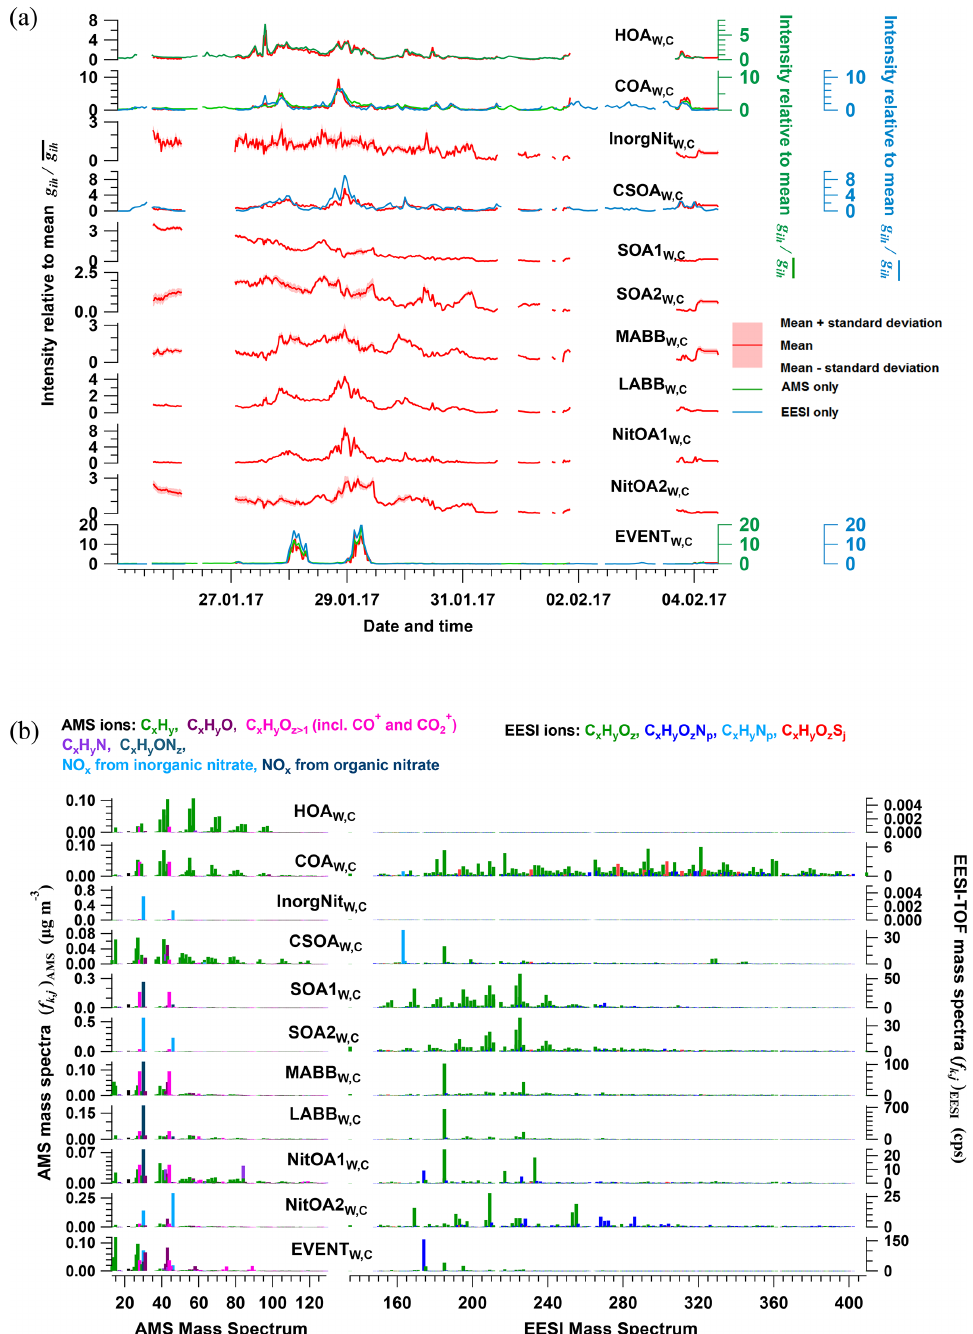
Figure 4. Average factor time series (a) and factor profiles (b) , which are calculated as the mean of all accepted bootstrap runs (308 runs in total). In panel (a) , the average factor time series are shown in red, and corresponding AMS and/or EESI-TOF factors from standalone PMF are shown in green and blue, respectively. Shaded areas represent the standard deviation across all accepted runs and are summarised in Table S2. In panel (b) , the average factor profiles are coloured by different ion families. Here, the AMS factor profiles are in the unit of µgm − 3 (each factor sums to 1µgm − 3 ), whereas the EESI-TOF spectra are in the unit of cps (each factor sums to total signal derived from 1µgm − 3 of the factor). Note that the NO + and NO + signals are divided into inorganic and organic 2